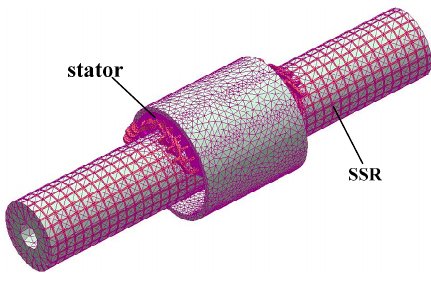
Figure 10. 3D FEM model of rotary part.